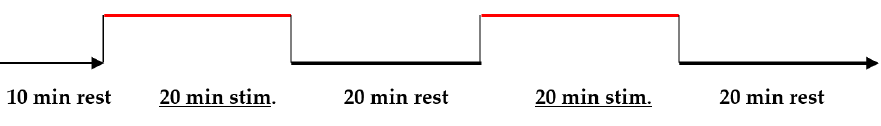
Figure 3. The time protocol of the experiment. Percutaneous auricular VNS (pVNS) was performed with three needle electrodes lo- cated in vagally innervated regions of the auricle, in/around the cymba conchae (Figure 4). Stimulation sequence comprised monophasic pulses of alternating polarity, repeated every 1 s (amplitude 4 V, pulse duration 1 ms).